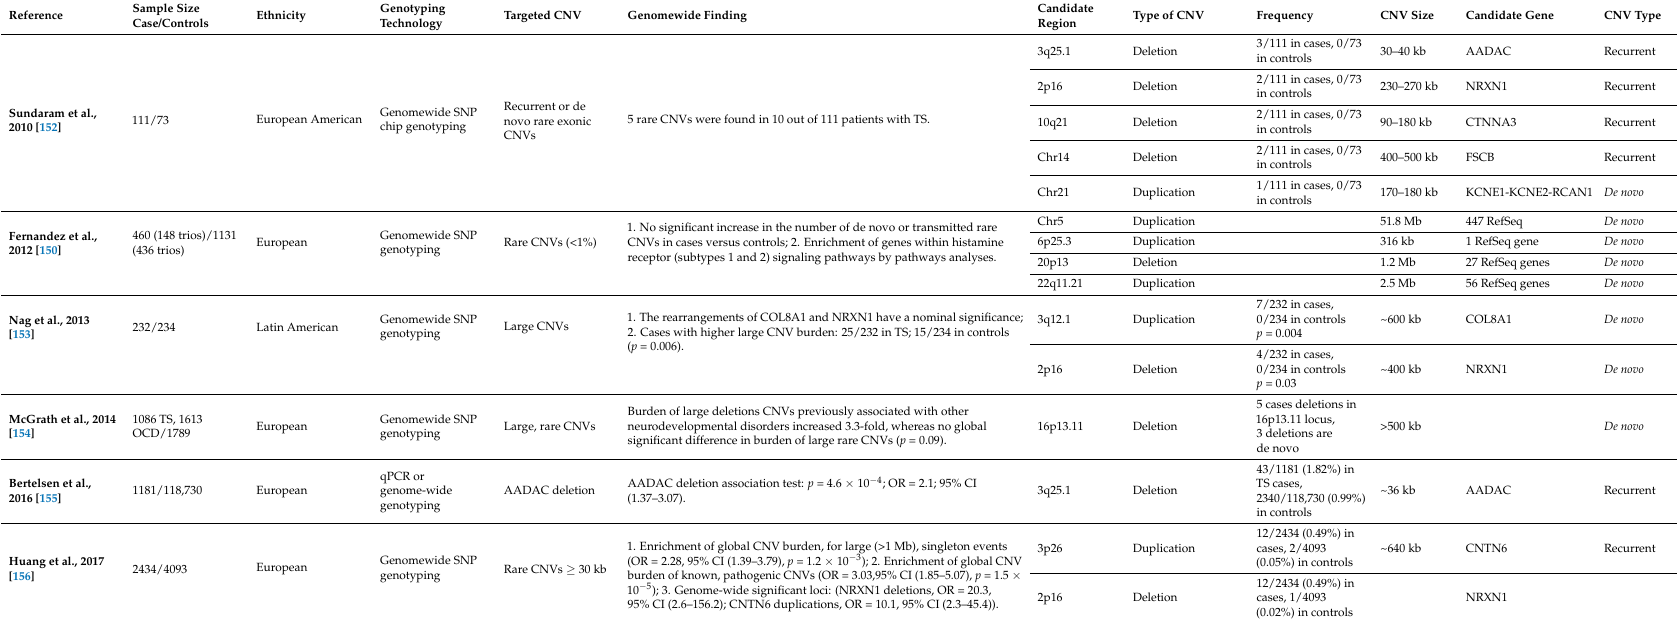
Table 4. Copy number variations in